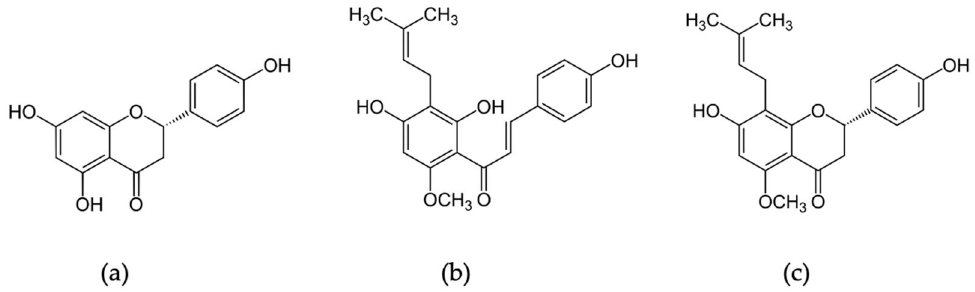
Figure 7. Chemical structures of the tested flavonoids: ( a ) naringenin, ( b ) xanthohumol and ( c ) iso ‐ xanthohumol.